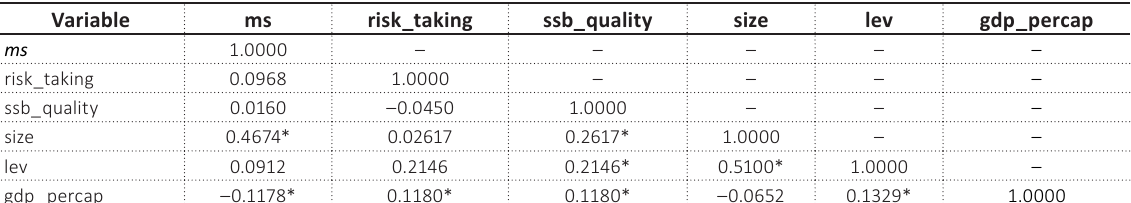
Table 5. Matrix correlation